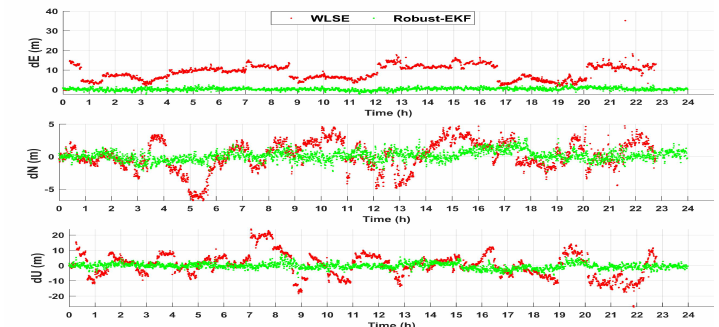
Figure 6. Comparison of position errors between robust-EKF and